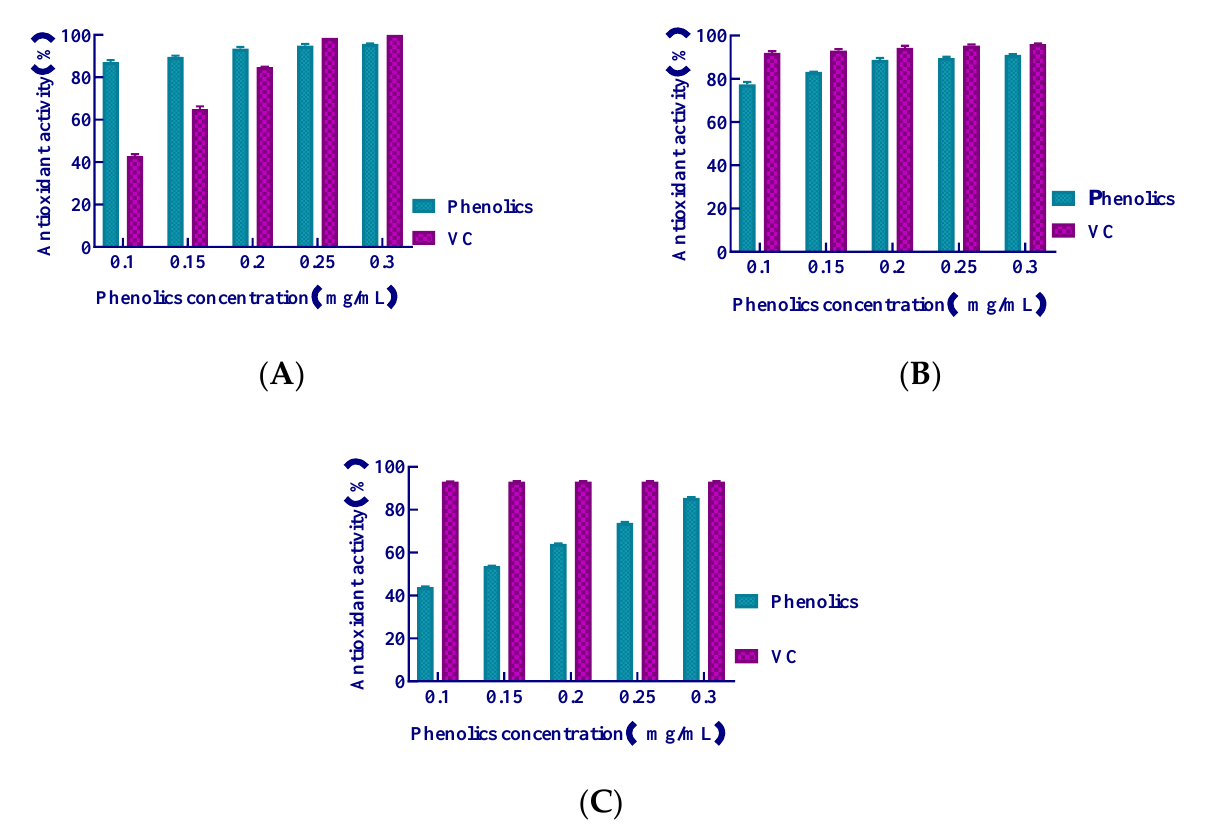
Figure 5. The experimental results of antioxidant activity of polyphenols. The • OH-scavenging activity of S. baumii polyphenols is higher compared with that of VC (Figure 5A). The free-radical scavenging ability of the polyphenols increased with an increase in the concentration of the extracted polyphenols. The scavenging ability was as high as 95.71% when the polyphenols concentration was 0.30 mg/mL. The scavenging ability was comparable to, or even higher than, VC at low